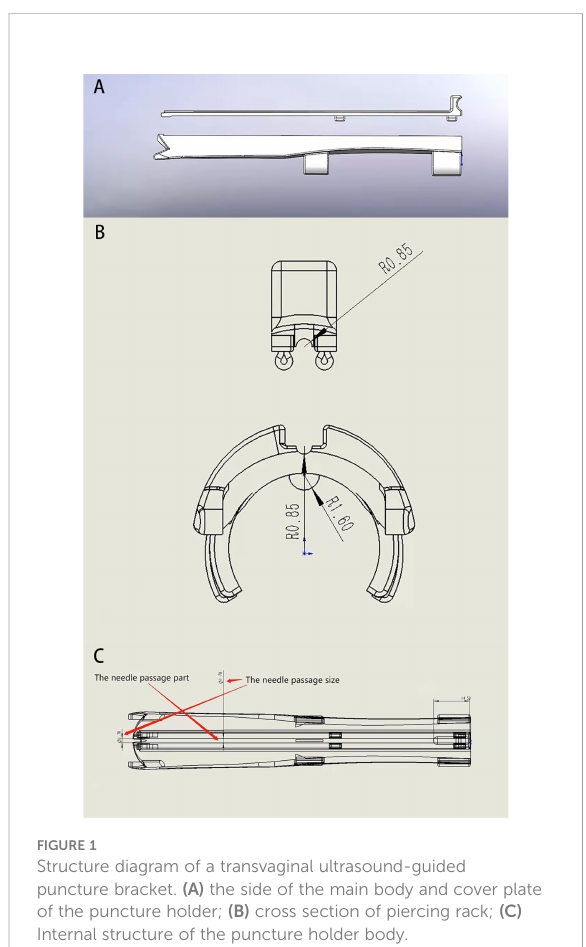
FIGURE 1 Structure diagram of a transvaginal ultrasound-guided puncture bracket. (A) the side of the main body and cover plate of the puncture holder; (B) cross section of piercing rack; (C) Internal structure of the puncture holder